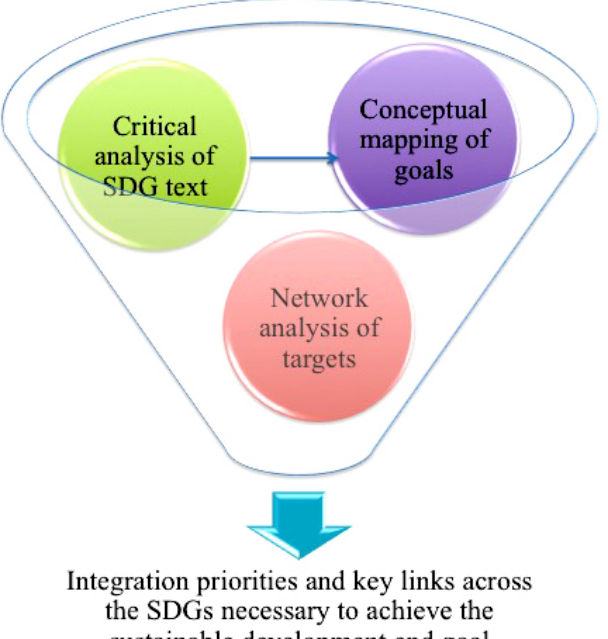
Fig. 1. Flowchart of the relationships among the three types of methods: textual analysis, conceptual modeling, and keyword network